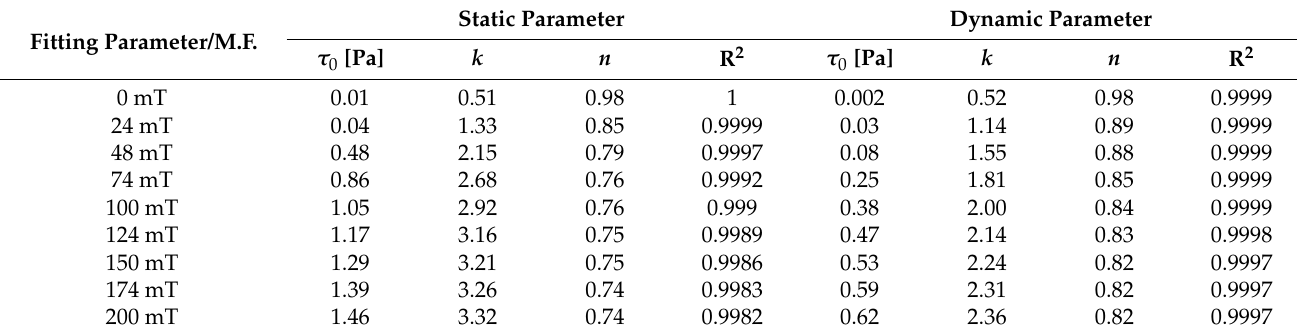
Table 3. The fit parameters and decision coefficient(R2) obtained using the H–B model.